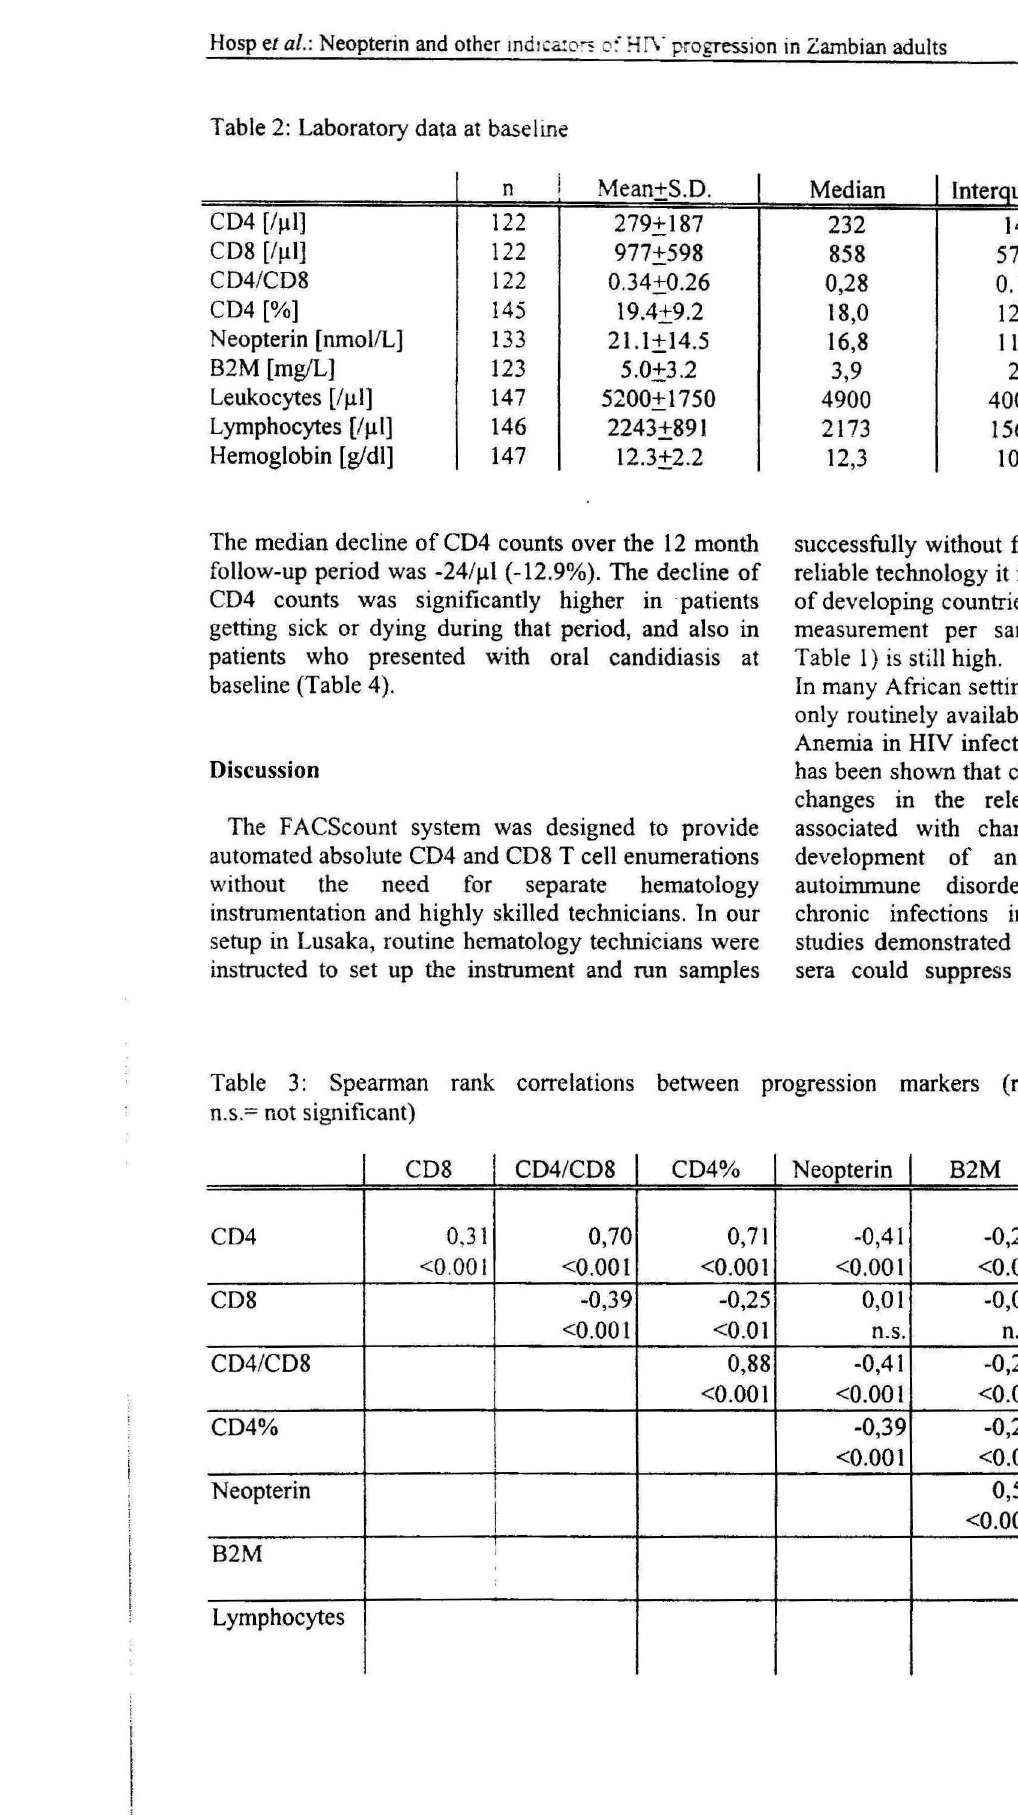
Table 2: Laboratory data at baseline